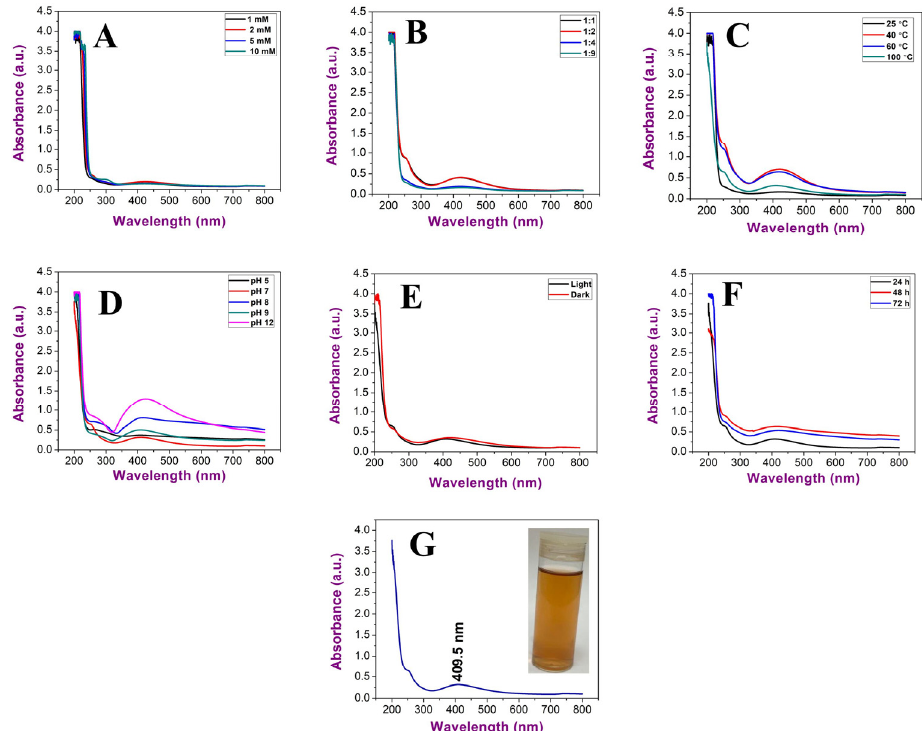
Figure 5. UV–Vis spectroscopy graphs illustrating the influence of ( A ) AgNO 3 concentration, ( B ) ratio between algal extract and AgNO 3 , ( C ) temperature, ( D ) pH, ( E ) illumination conditions, and ( F ) incubation duration and ( G ) Uv@Ag-NPs under optimum conditions.